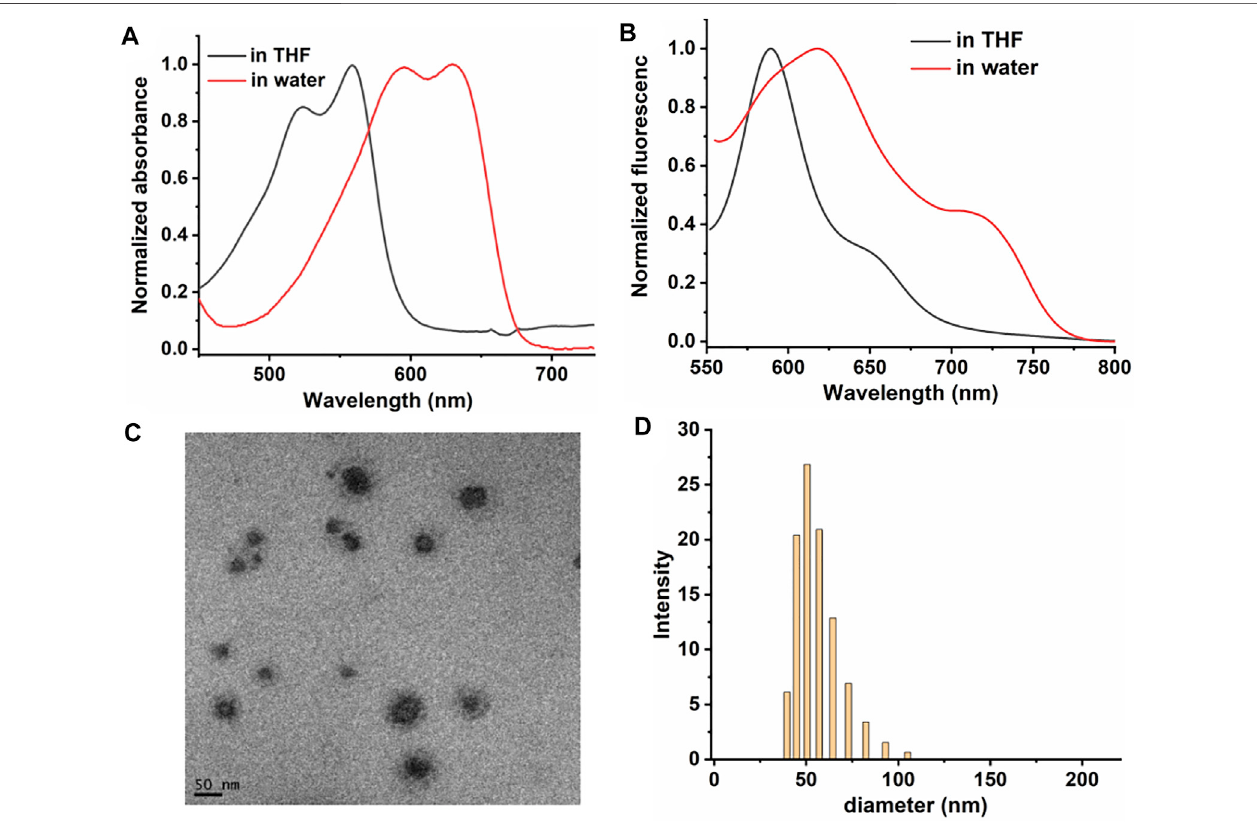
FIGURE1| Normalized (A) absorbancespectraofDPPA. (B) fl uorescencespectraofDPPAinTHFandNPsinwater. (C) TEMofDPPANPs. (D) DLSofDPPANPs in water.